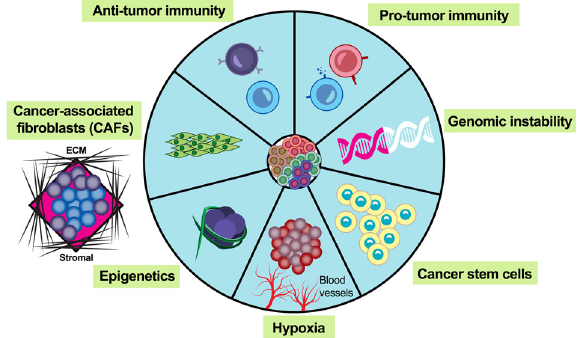
Fig. 2 The heterogenous tumor microenvironment. The tumor microenvironment possesses a dynamic topography within the tumor and is composed of cancer-associated fi broblasts, stromal cells, extracellular matrix, and immune cells. Hypoxic status, vasculature, and epigenetics, all may have a complex crosstalk with prostate cancer cells in dynamic